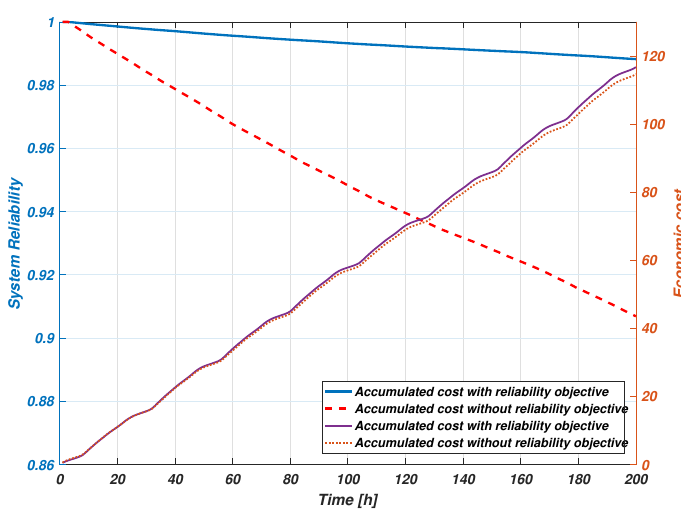
Figure 6. Evaluation of system reliability and accumulated economic cost for three tanks.